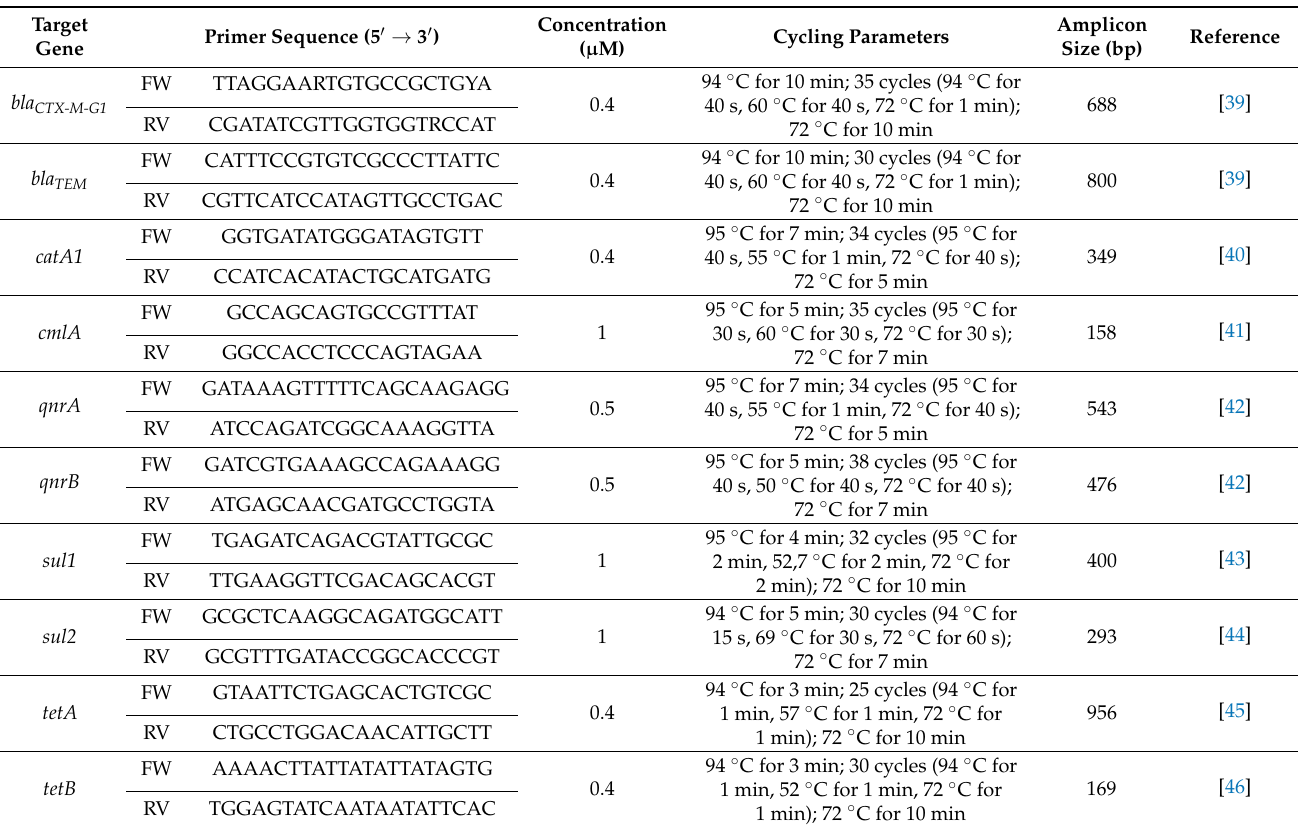
Table 2. Conventional PCR primers used in this